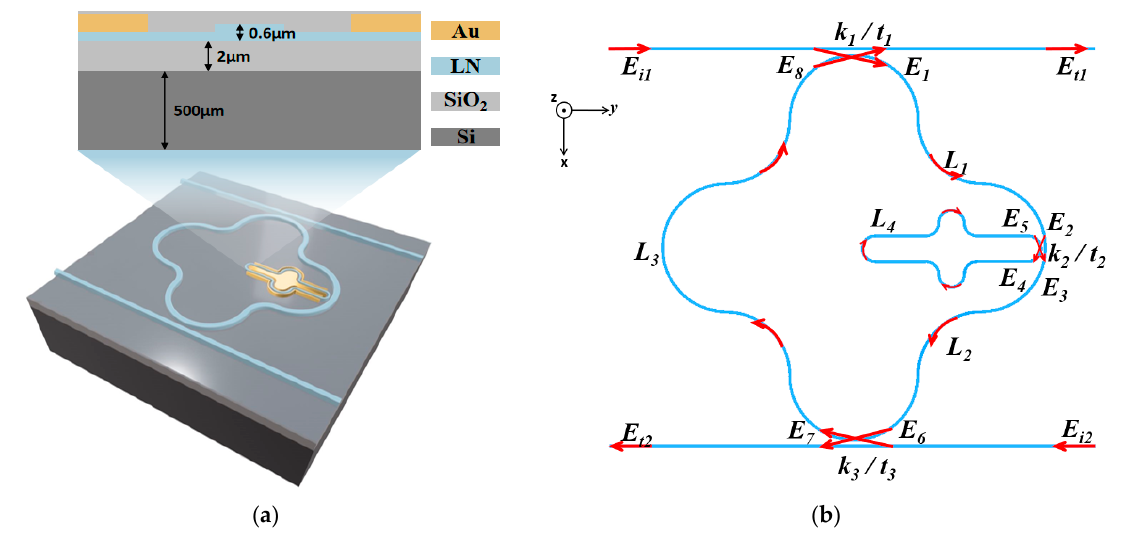
Figure 1. ( a ) Schematic diagram of the structure of the double ring modulator, where the enlarged area is a crossing-section view of the devices. ( b ) Parameter distribution in the schematic diagram of double ring structure, including transmission coefficient ( t ), coupling coefficient ( k ), waveguide length ( L ), and the intensity of light fi eld ( E ).